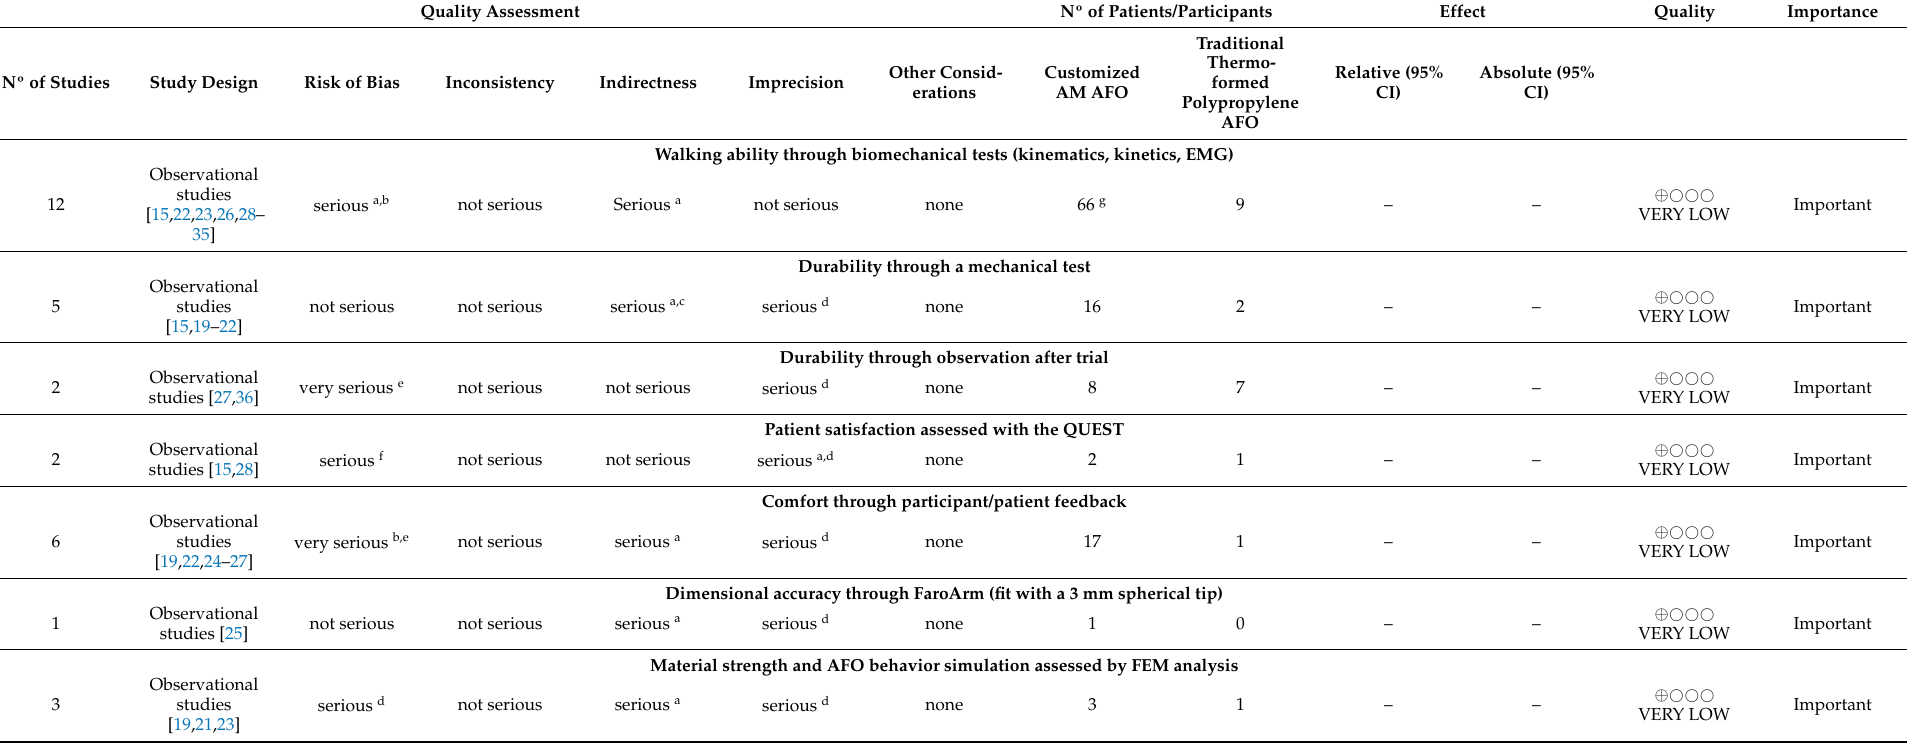
Table 2. GRADE evidence